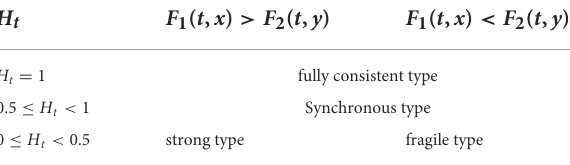
TABLE 1 Division of coordination